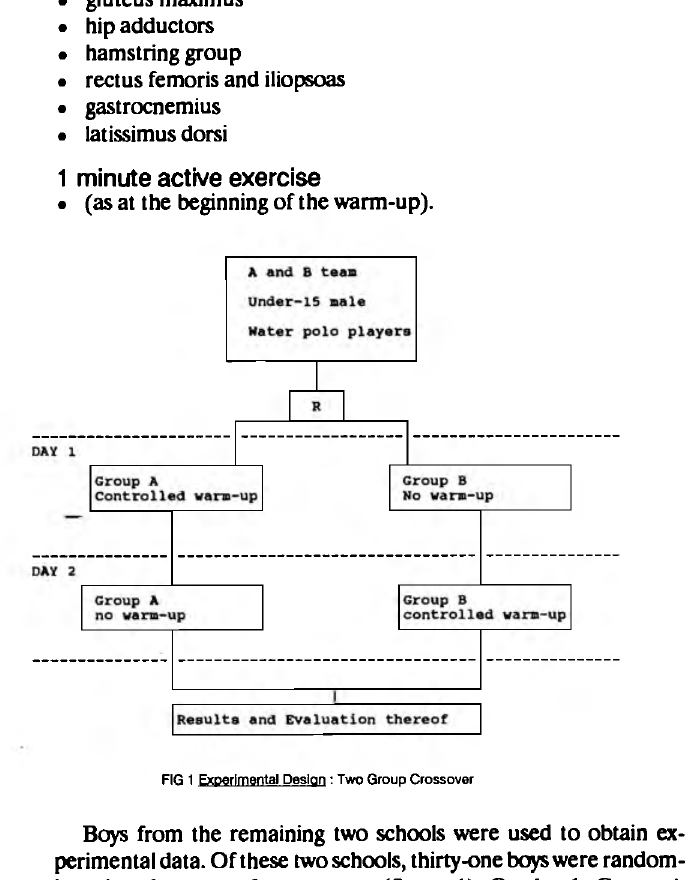
FIG 1 Experimental Design: Two Group